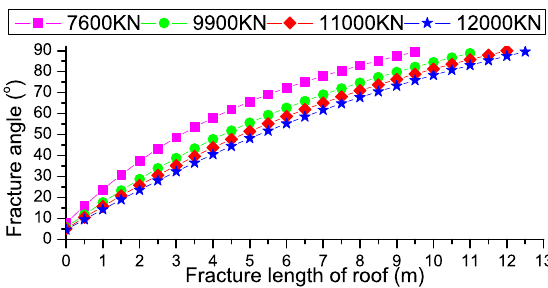
Figure 5. Relationship between the fracture step and the fracture angle at different work resistances of the support.